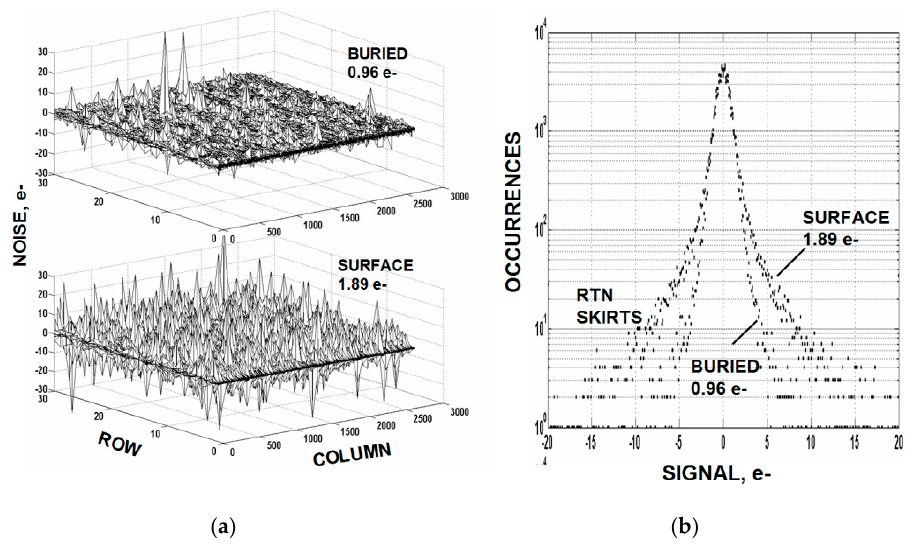
Figure 9. Noise performance comparison for surface and buried channel SF MOSFETs. The data shows that the buried channel device has reduced RTN but not reduced 1/ f noise.